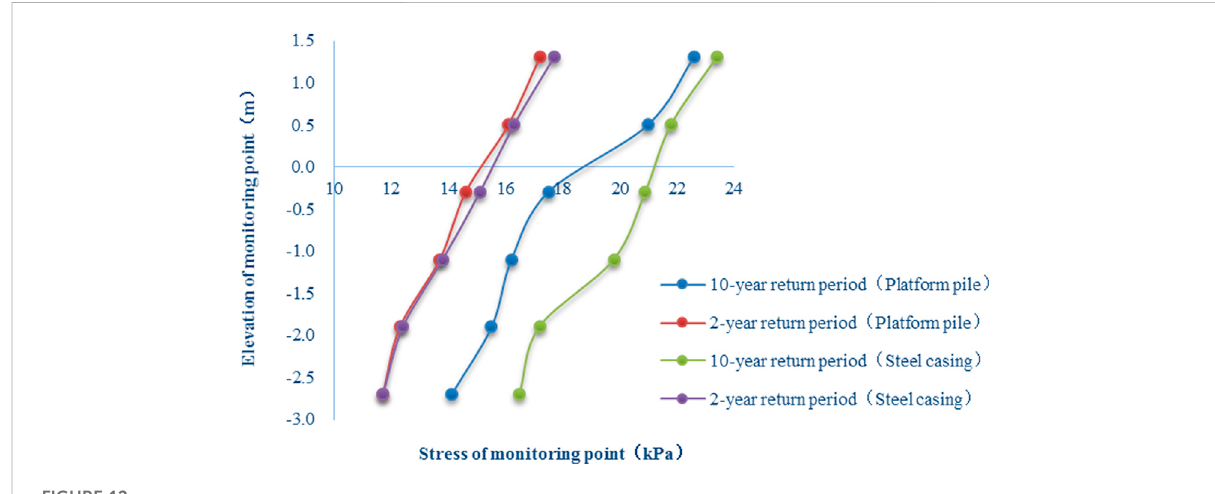
FIGURE 12 Distribution of the horizontal pressure on platform pile and steel casing along the vertical